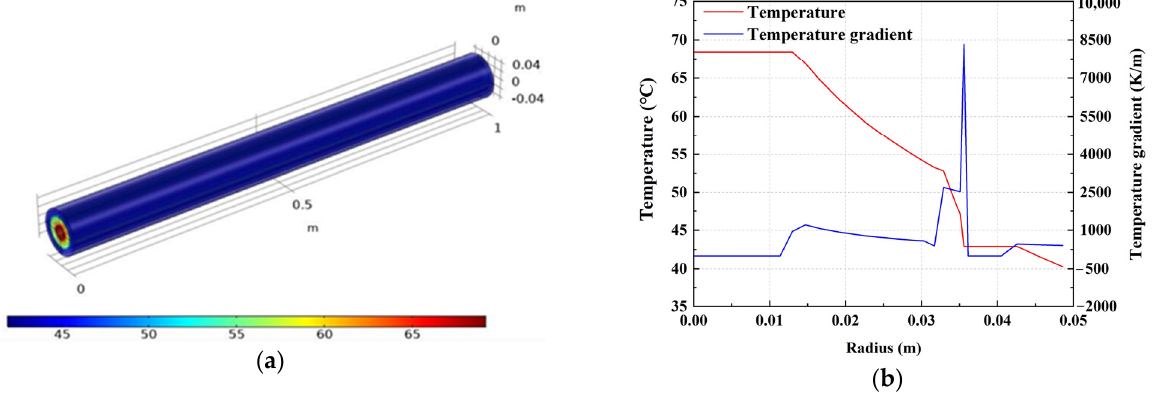
Figure 5. The temperature distribution of the cable: ( a ) the axial temperature distribution of the cable; ( b ) the temperature and temperature gradient distribution of the cable section.